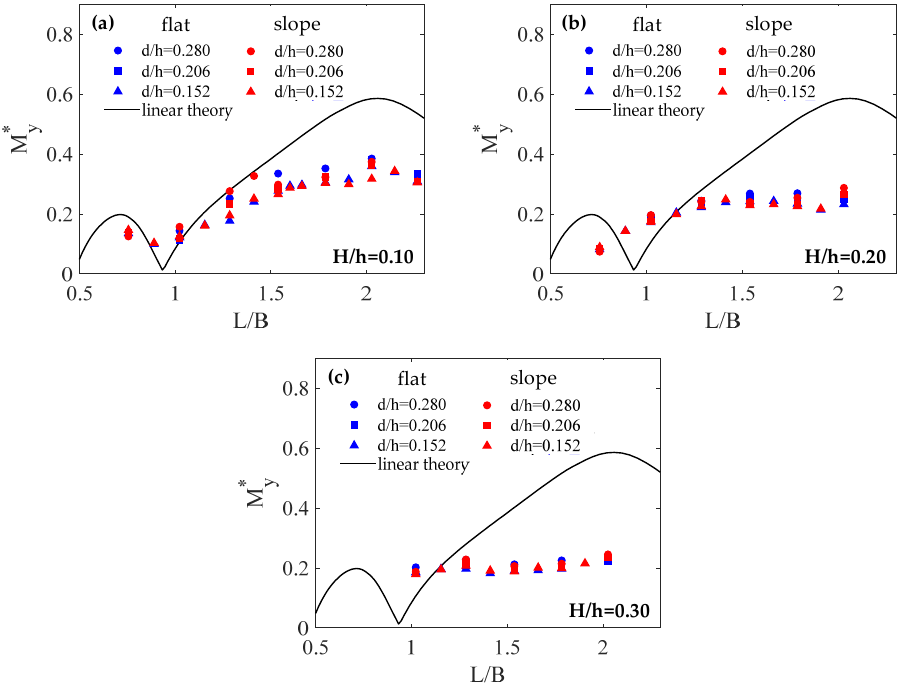
Figure 9. The overturning moments due to regular waves in terms of the different relative wave heights ( a ) H/h = 0.10, ( b ) H/h = 0.20 and ( c ) H/h = 0.30.